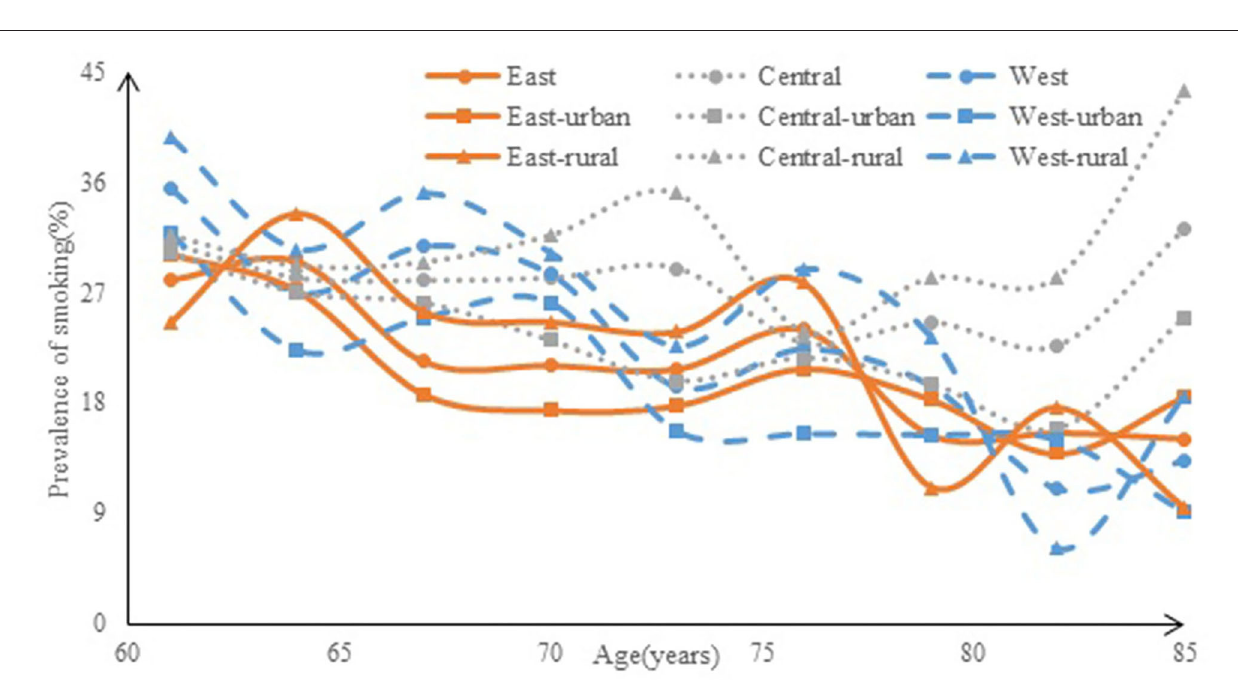
Frontiers in Public Health |